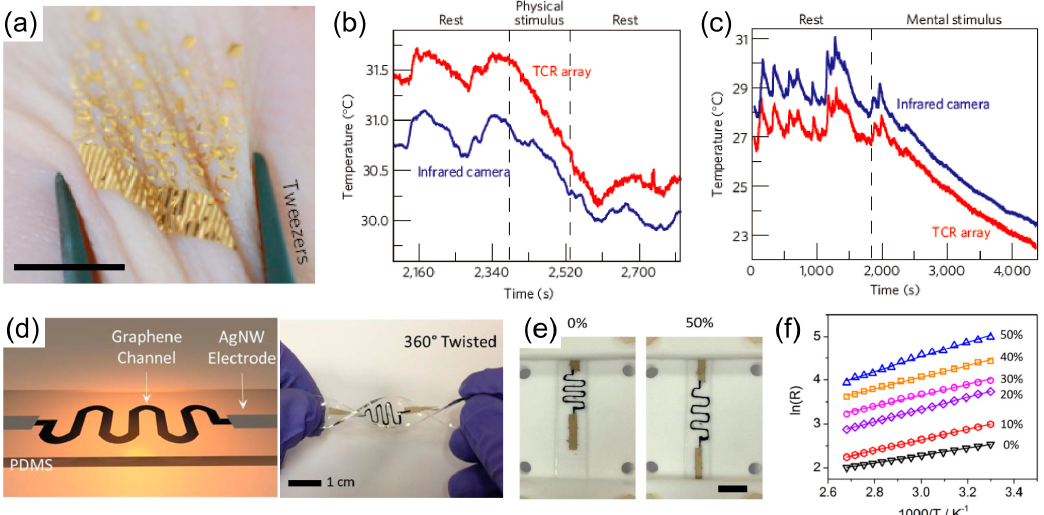
Figure 1. Wearable temperature sensors. ( a ) Image of a 4 × 4 temperature coefficient of resistance (TCR) sensor array after application to the skin deformed by pinching the skin in a twisting motion (scale bar 8 mm). ( b ) Temperature of the palm measured with an infrared camera (blue) and a sensor array (red, offset for clarity) during mental and ( c ) physical stimulus tests. Reprinted with permission from Ref. [42]. Copyright 2016, Nature Publishing Group. ( d ) Schematic diagram and representative image of the stretchable graphene thermistors at twisted states (scale bar 1 cm). ( e ) Images of the stretchable graphene thermistor at 0% and 50% strains (scale bar 1 cm). ( f ) Resistance variation with temperature (30 to 100 °C) within 0% to 50% strains (step 10%). Reprinted with permission from Ref. [31]. Copyright 2015, American Chemical Society.